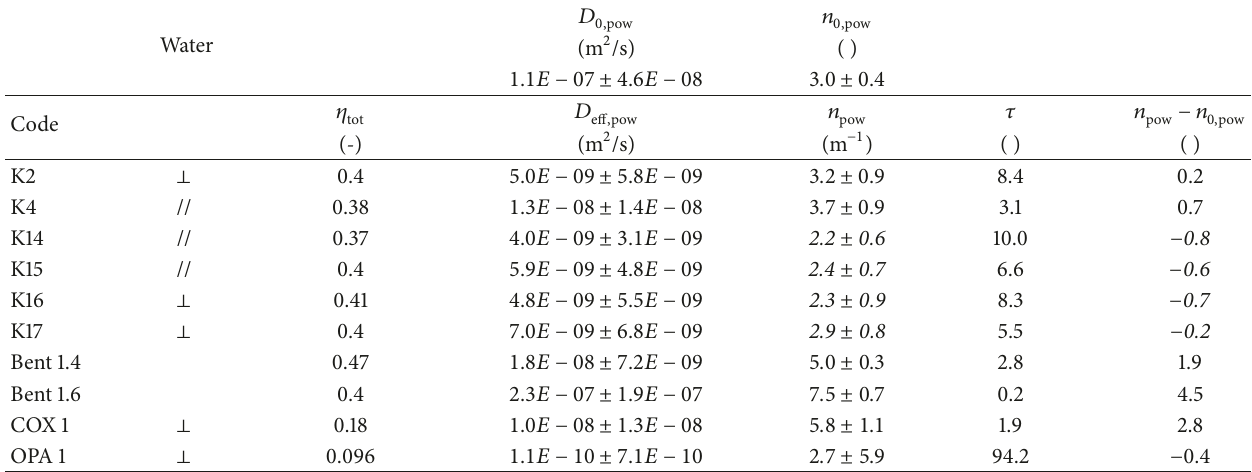
Table 7: Parameter values obtained by fitting the effective diffusion coefficient vs. size of the diffusing molecule by the power law expression (15). The numbers in the top line are taken from [23]. “Tortuosity” 𝜏 is defined similarly as expression (17).